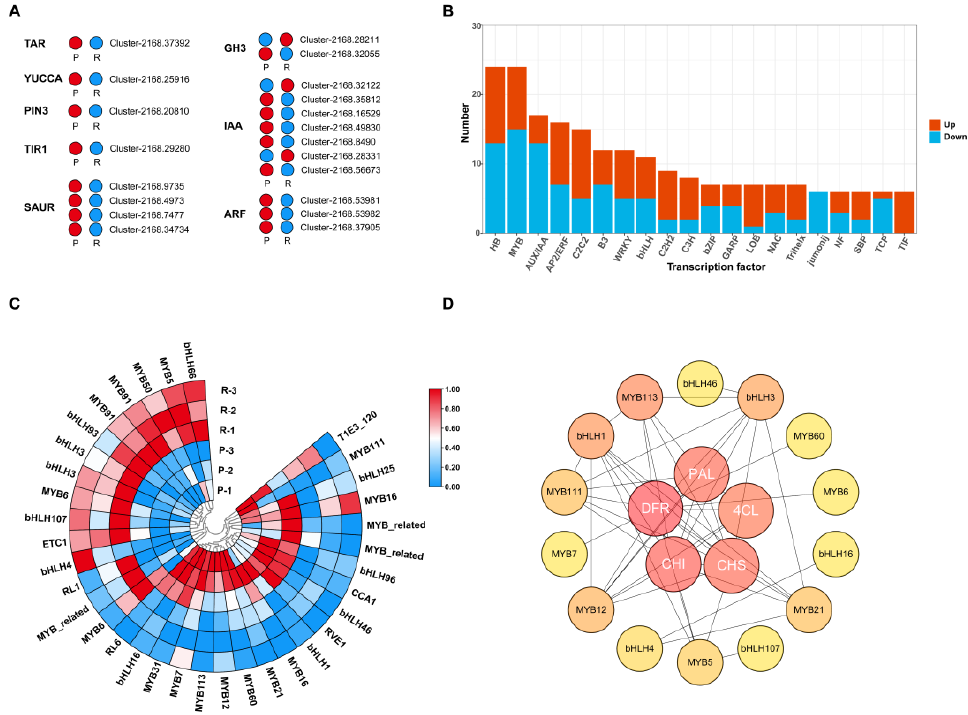
Figure 4. Differentially expressed genes (DEGs) involved in auxin signal transduction and differentially expressed transcription factors (TFs). ( A ) Heatmap of DEGs involved in auxin signal transduction. Red, up-regulated; blue, down-regulated. TAR, tryptophan aminotransferase-related protein; PIN3, PIN-FORMED3 (PIN3)-mediated auxin transport; TIR1, transport inhibitor response 1; SAUR, small auxin-up RNA; GH3, Gretchen Hagen 3; IAA, indole-3-acetic acid; ARF, auxin response factor. ( B ) Differentially expressed TFs in red and pink petal region samples. Red columns, up-regulated TFs; blue columns, down-regulated TFs. ( C ) Heatmap of differentially expressed MYB and bHLH TFs; each row was independently normalized according to FPKM value. Blue, low expression; red, high expression. ( D ) Protein-protein interaction network of genes involved in the MYB, bHLH, and flavonoid pathways; deeper color node indicates higher degree score.